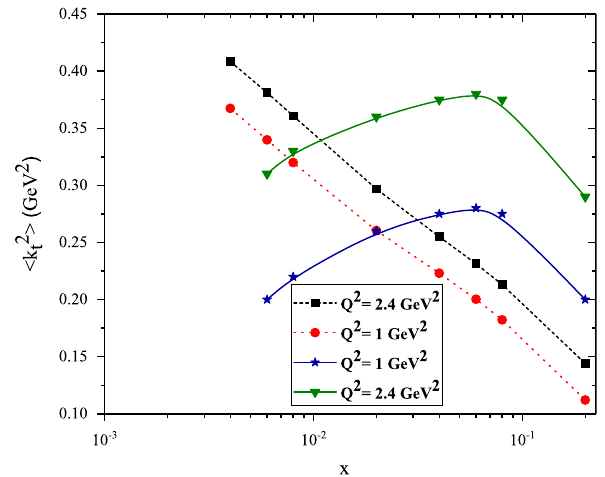
Fig. 7 The plot of (cid:2) k 2 t (cid:3) versus x for the average transverse momentum of u quark (dotted curves) and those of reference [56] (full